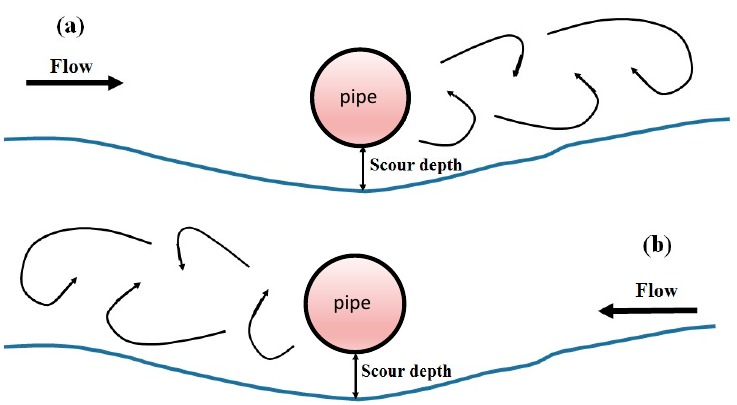
Figure 3. Schematic drawing of scouring vortices due to waves at a submarine pipeline. Wake vortexes downstream of the pipeline ( a , b ) due to oscillatory flow.